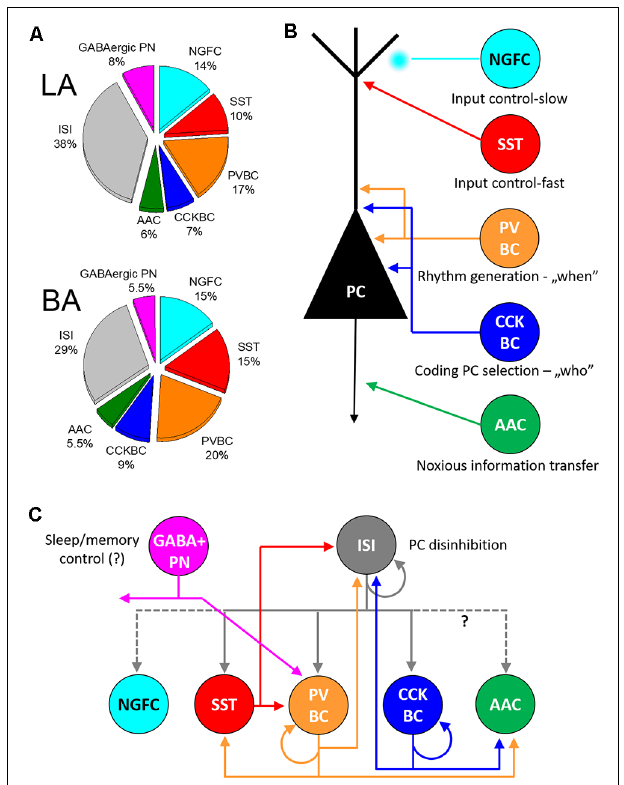
FIGURE 3 | Inhibitory cells, their connectivity, and proposed functions in the circuits of the basolateral amygdala. (A) Ratio of distinct types of GABAergic cells in the lateral (LA) and basal amygdala [BA; adopted from (Vereczki et al., 2021)]. (B) Five interneuron types innervating the distinct membrane domains of principal cells (PC) may play different roles in circuit operation. (C) Connectivity matrix among GABAergic neurons in the basolateral amygdala. Possible functions for GABAergic projection neurons (GABA+ PN) and interneuron-selective interneurons (ISI) are indicated. NGFC, neurogliaform cells expressing NPY; SST, dendrite-innervating interneurons expressing somatostatin; PVBC, parvalbumin-containing basket cells; CCKBC, cholecystokinin-expressing basket cells; AAC, axo-axonic